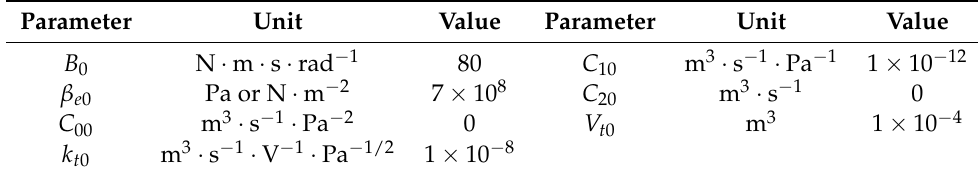
Table 2. Nominal system parameters of the EHSS for backstepping control design.